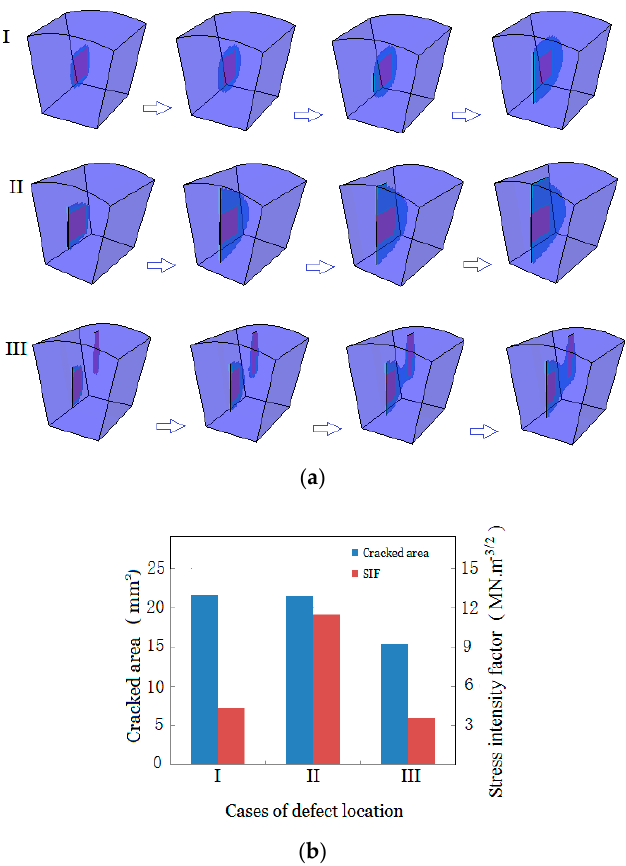
Figure 9. Different defect ( a ) evolutions; ( b ) susceptibilities to cracking. Figure 9. Di ff erent defect ( a ) evolutions; ( b ) susceptibilities to